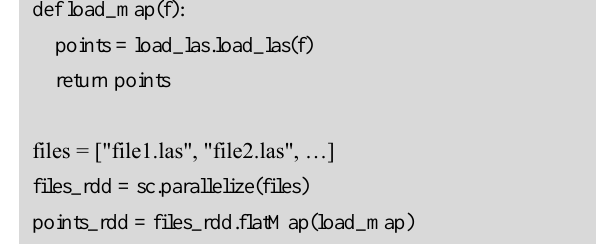
Figure 4: Pseudo code of a naïve mapping function for sideloading LiDAR